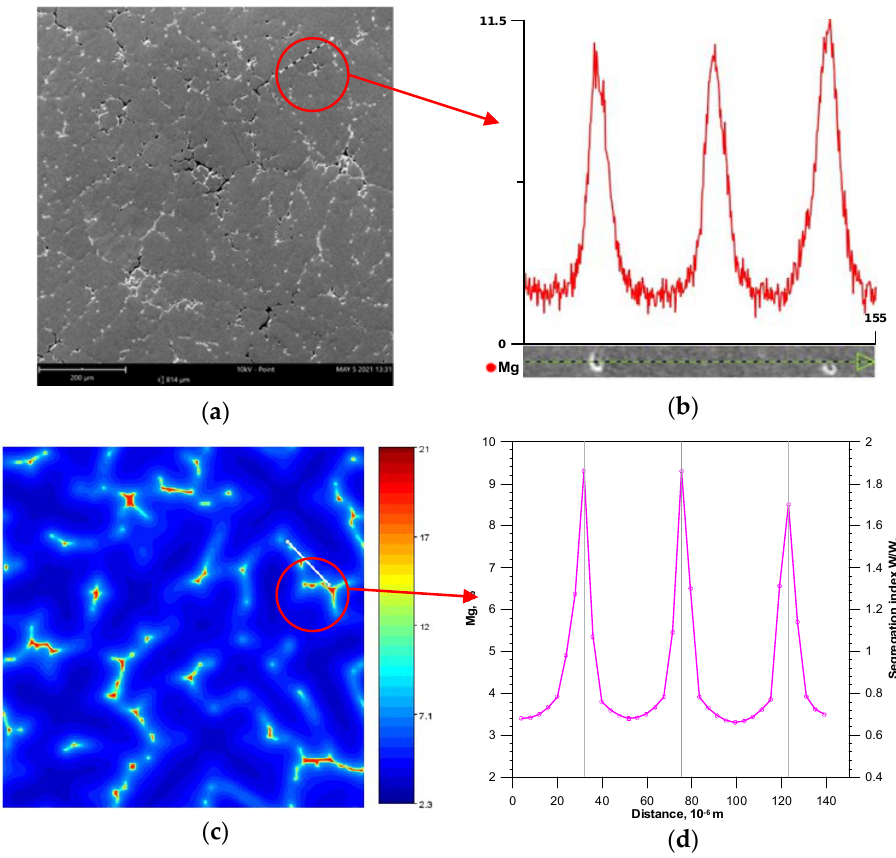
Figure 11. Microstructure test results: ( a ) die casting ( b ) magnesium concentration profile in the selected area of the die casting, ( c ) surface Mg distribution calculated from the CA model ( f S = 0.99) ( d ) magnesium concentration profile determined from the CA model.